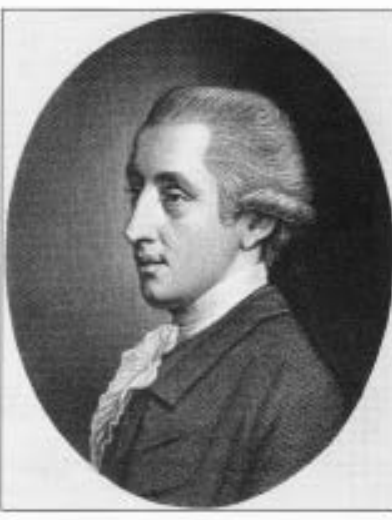
Figure 2 The pioneer anatomist and physiologist William Hewson (1739-74); engraving by R. Stewart,